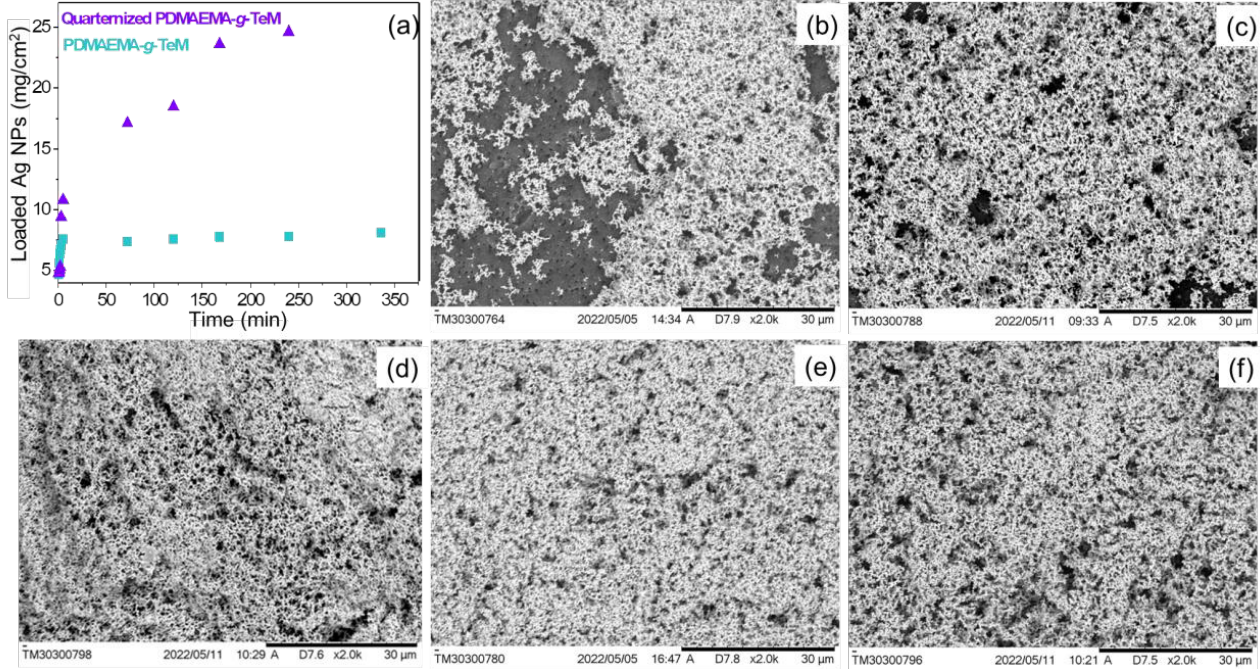
Figure 6. Loading of Ag NPs onto PDMAEMA- g -TeM (DG: 22%) and quaternized PDMAEMA- g -TeM of the same DG ( a ). SEM images of PDMAEMA- g -TeM (DG: 22%) surface after 30 min ( b ), 5 h ( c ), and 24 h of Ag NPs loading ( d ). SEM images of quaternized PDMAEMA- g -TeM surface (same DG) after ( e ) 2 h and 24 h of Ag NPs loading ( f ).